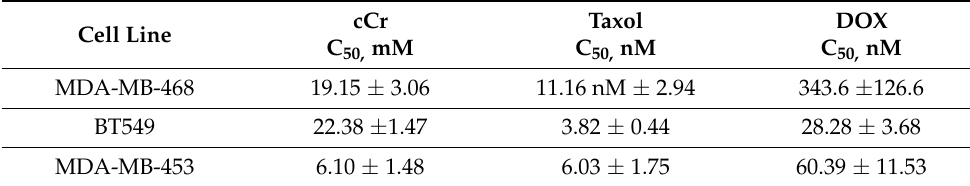
Table 2. Calculation of monotherapy IC 50 values in human TNBC cell lines. IC 50 values ± SEM were determined at 96 h, as described in the Materials and Methods. IC 50 values for independent experiments were calculated using non-linear regression and variable slope fit in Prism 9.0. Results from independent experiments were averaged to report the mean ( n = 4 replicates/cell line / drug). Cell Line